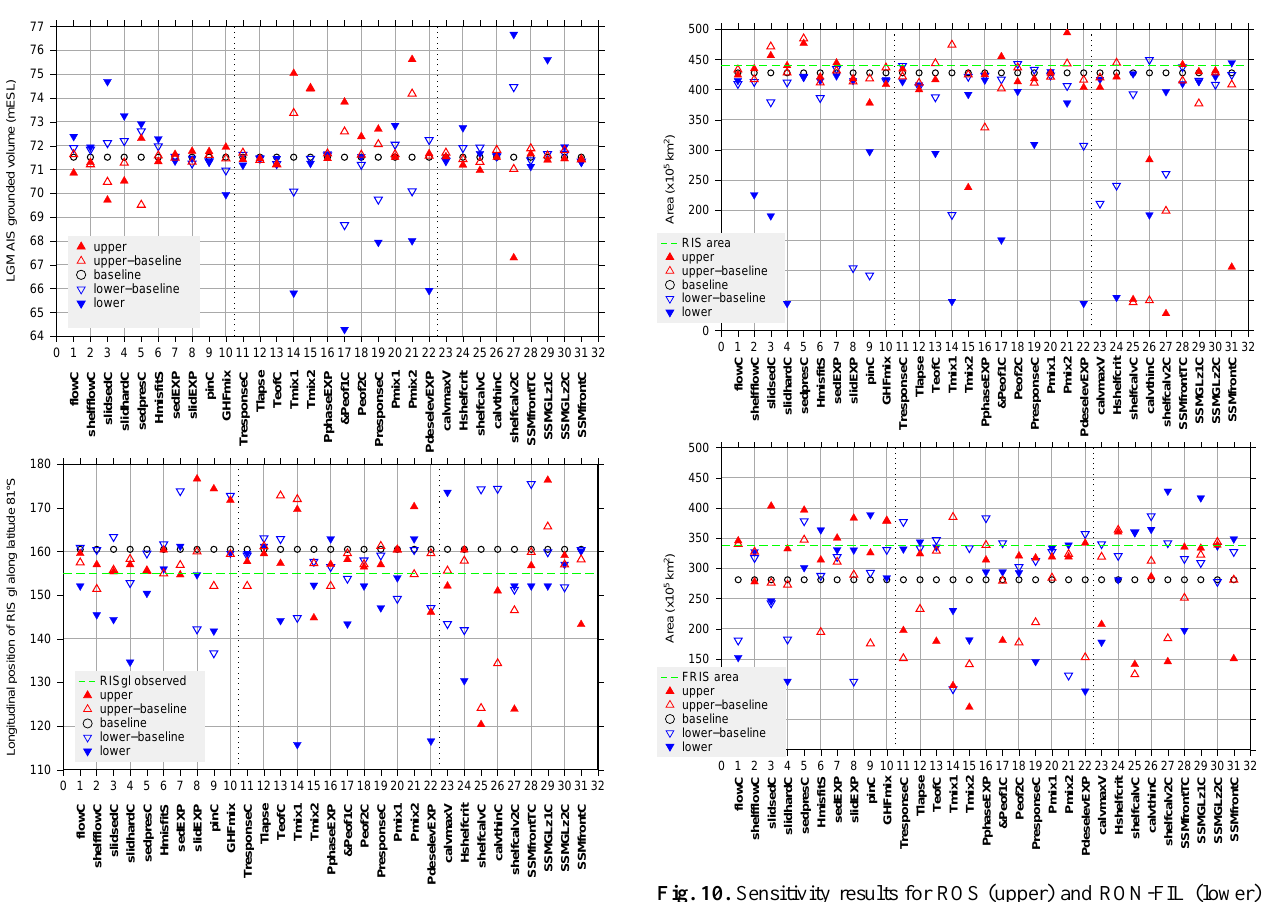
Fig. 9. Sensitivity results for total AIS grounded volume (upper) at LGM and present-day ROSgl position (lower). Note the latter met- ric misfit from observation for the baseline run is ∼ 100km, which equates to 2–3 grid cells.